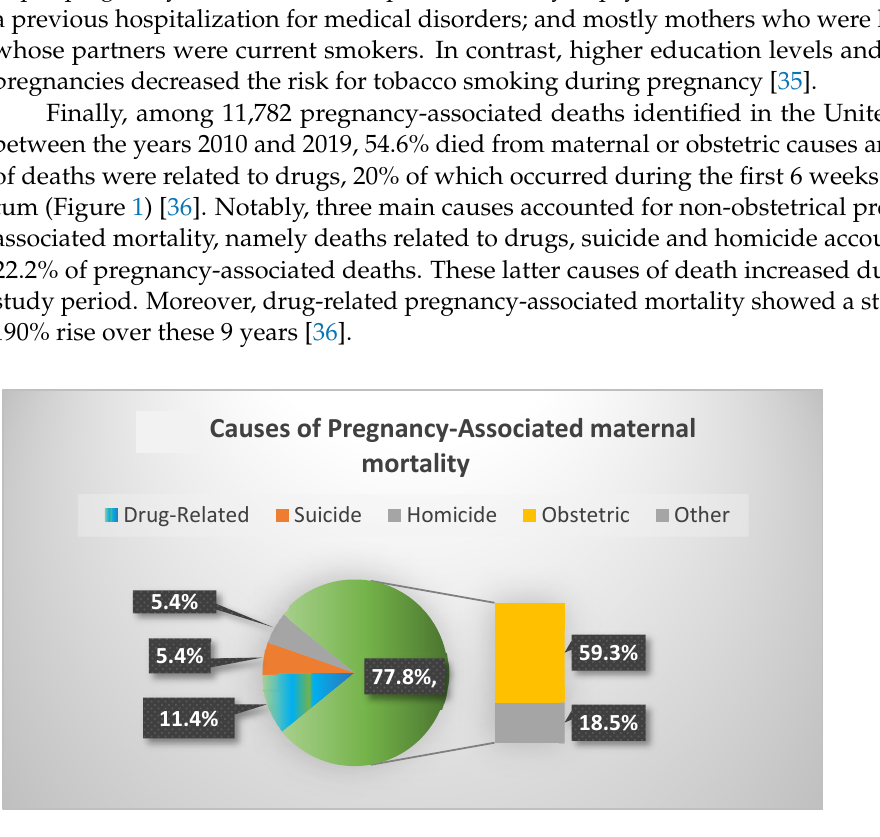
Figure 1. Drug ‐ related deaths, suicide and homicide accounted for 22.2% of pregnancy ‐ associated Figure 1. Drug-related deaths, suicide and homicide accounted for 22.2% of pregnancy-associated deaths; 11.4% of pregnancy ‐ associated mortality was caused by drug use [36] . deaths; 11.4% of pregnancy-associated mortality was caused by drug use